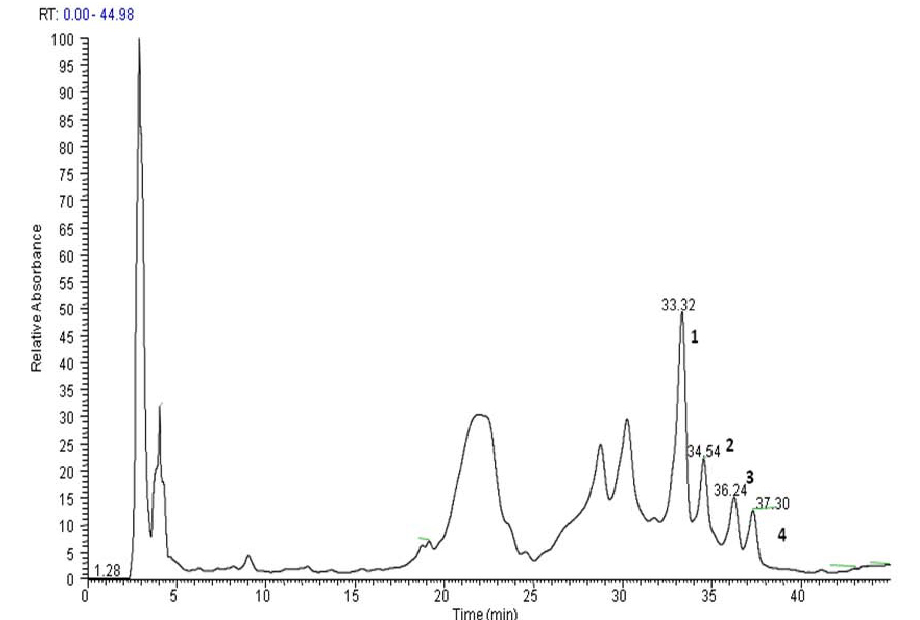
Figure 1. Total ion chromatogram (TIC) by negative ion mode electrospray ionization mass spectrometry (ESI/MS) of the phorbol esters (PEs)-rich fraction. Peaks 1–4 indicate the four derivatives of PE at retention times between 33.32 and 37.30